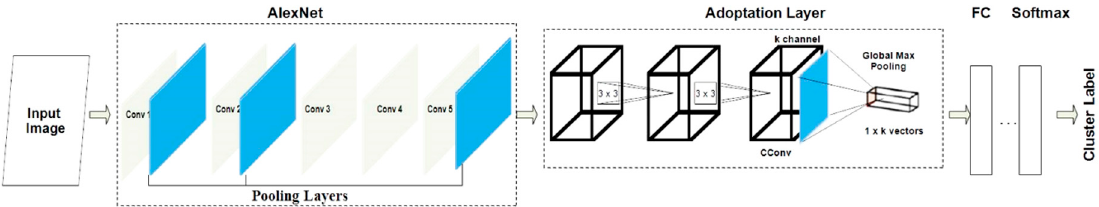
Figure 2. A proposed unsupervised Convolution Neural Network (CNN) based network architecture, that consists of few convolutional layers, followed by some adjustment to convolution layers with one clustering convolution layer (CCnov), a fully connected layer, and Softmax layer.